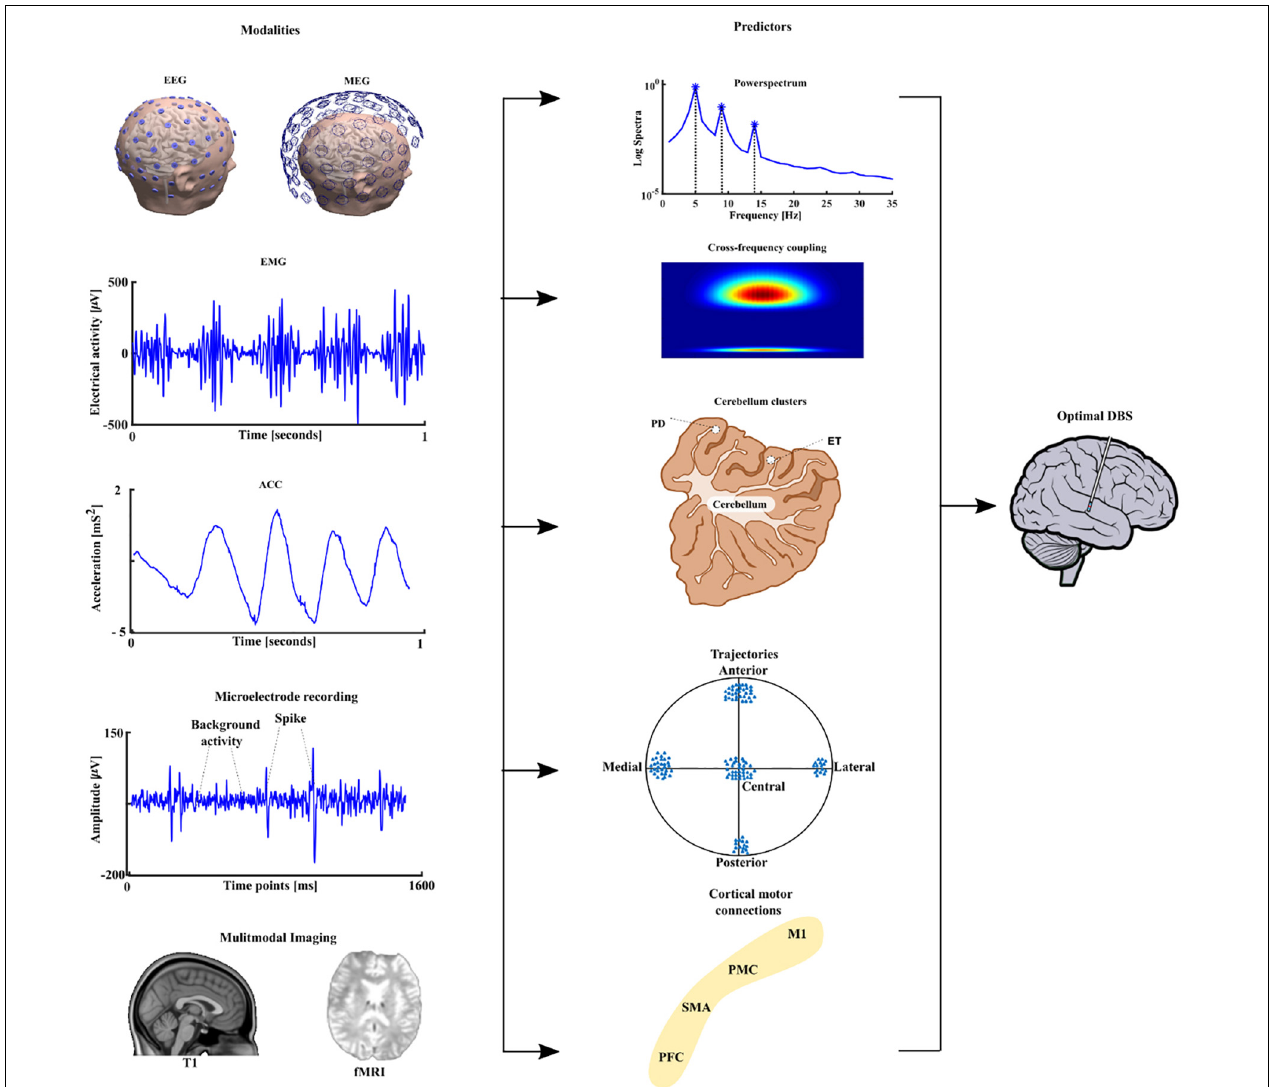
FIGURE 3 | The different modalities are depicted in the first column namely the electroencephalography (EEG), magnetoencephalography (MEG) followed by peripheral signals namely electromyography (EMG), accelerometer (ACC), microelectrode recording (MER), and neuroimaging namely structural T1 magnetic resonance imaging and functional magnetic resonance imaging (fMRI). The extracted predictors are shown in the second column power spectrum, cross-frequency coupling, source analyses-based cerebellum clusters for PD and ET. Trajectory based oscillatory predictors and finally cortical motor connectivity with the four main motor regions, primary motor cortex (M1), premotor cortex (PMC), supplementary motor area (SMA) and prefrontal cortex (PFC) to sub thalamic nucleus (STN). The multimodal integration of all these features can lead to optimal deep brain stimulation in PD